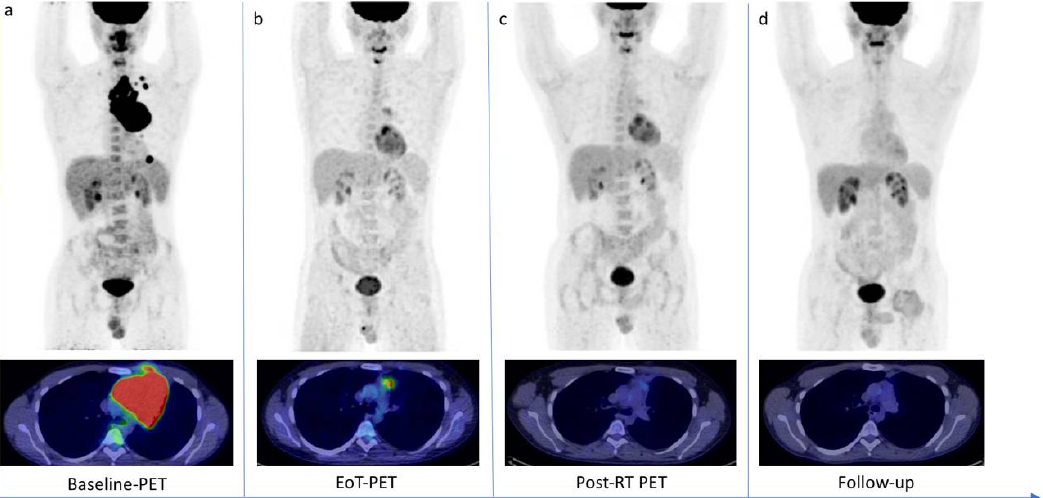
Figure 5. 18F-FDG PET/CT scans of a 30-year-old patient with diffuse large B cell Lymphoma. ( a ) Baseline-PET showed an abnormal hypermetabolic mediastinal tumoral lesion (SUVmax 34.3) with supradiaphragmatic lymph nodes involvement (SUVmax 28.1). The patient underwent six cycles of